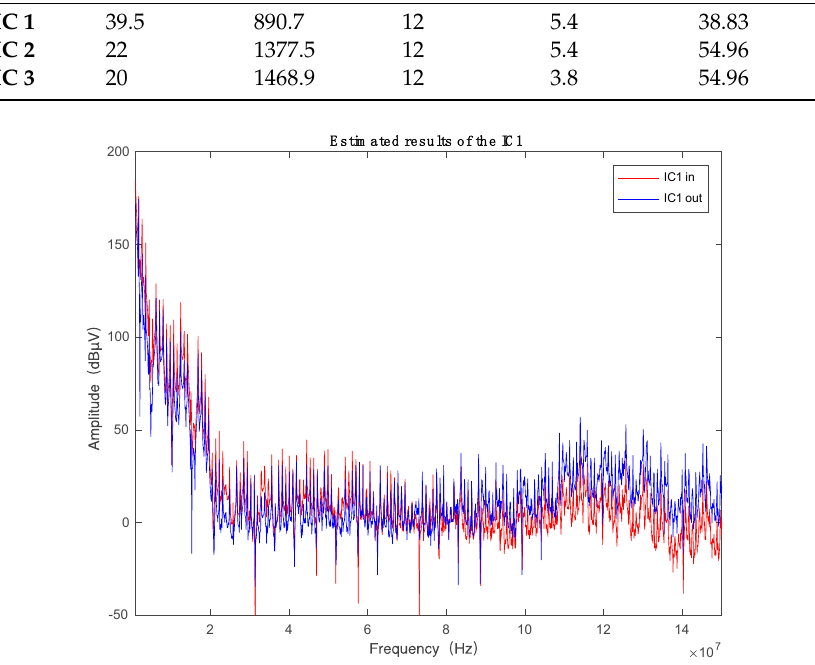
Figure 20. The estimated results of the IC sub-module 1.